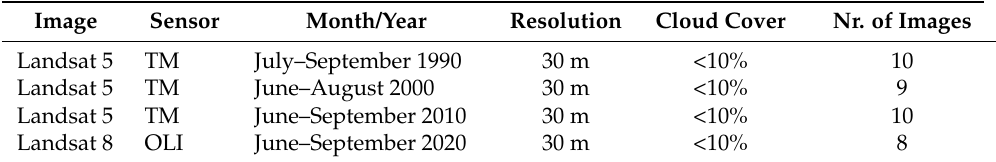
Table 1. Data of Landsat images (Dataset 1) used for classification of land use land cover changes in the High Atlas Mountains of Morocco. Image Sensor Month/Year Resolution Cloud Cover Nr. of Images Landsat 5